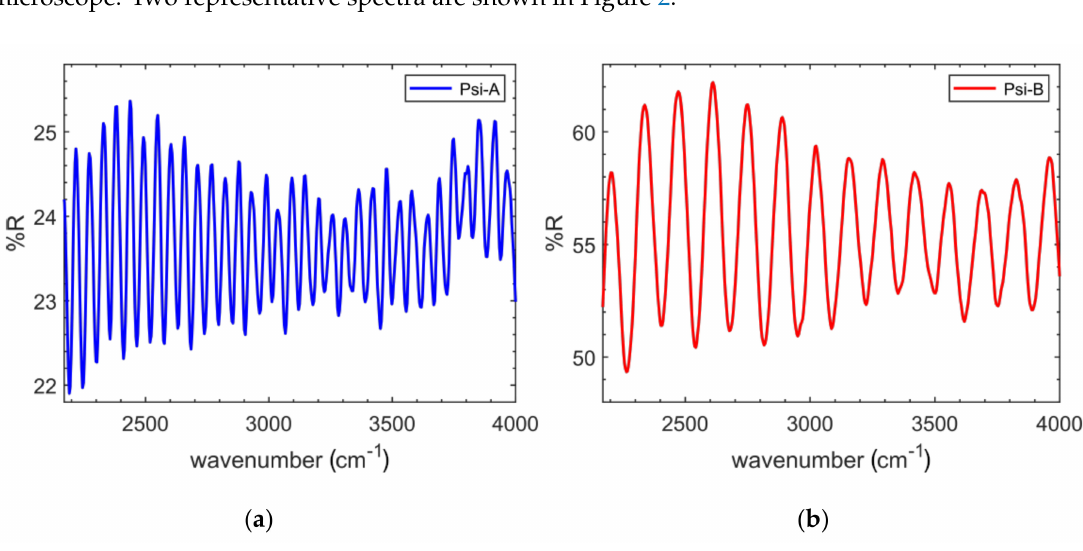
Figure 2. FTIR interferogram of ( a ) PSi-A sample and ( b ) of PSi-B